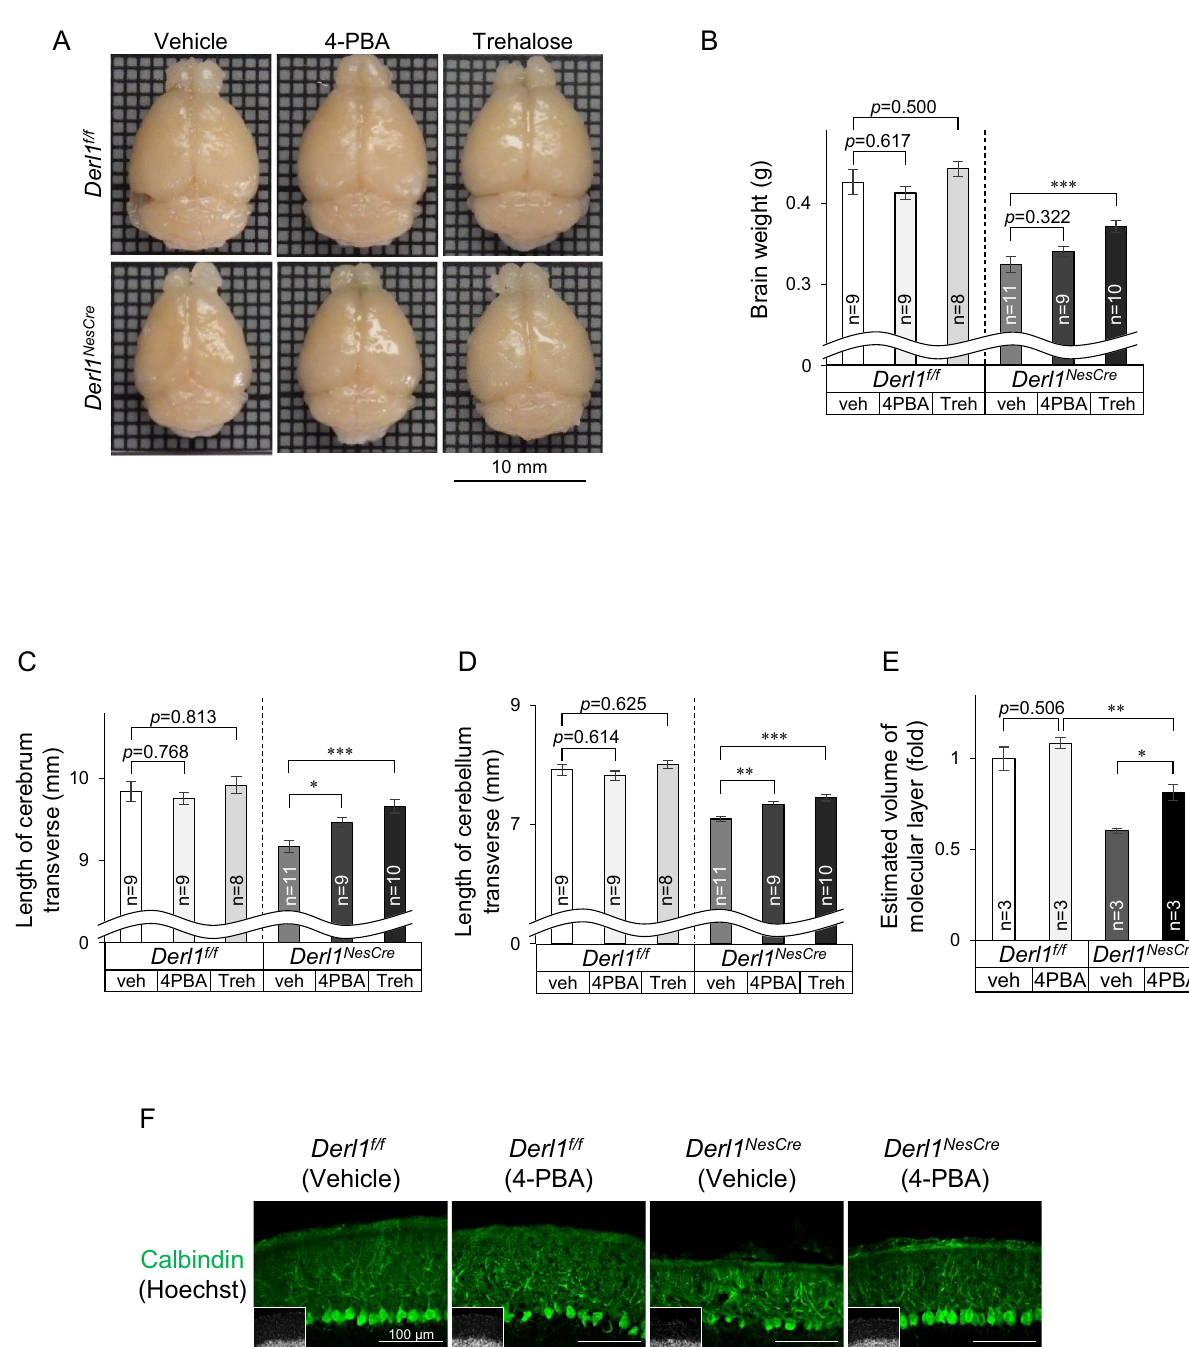
Figure 3. Chemical chaperone ameliorates brain atrophy. ( A – F ) Vehicle or chemical chaperone was administered via intraperitoneal injections once a day from P14 to 8 weeks of age. All mice were males ( A – F ). ( A ) Representative gross brain images between vehicle or chemical chaperone (4-PBA or trehalose)-treated Derl1 NesCre mice at 8 weeks of age. Scale bar, 10 mm. ( B ) Comparison of brain weight between vehicle or chemical chaperone (4-PBA or trehalose) treated Derl1 NesCre mice and their respective control mice. ( C , D ) Comparison of brain length between vehicle- or chemical chaperone (4-PBA or trehalose) treated Derl1 NesCr e mice and their respective control mice. Transverse diameters on photographs of the cerebrum ( C ) and cerebellum ( D ) were measured, respectively. ( E ) Volumetric analysis of the molecular layer of the cerebellum in Derl1 NesCre mice and their respective control mice at 8 weeks of age after vehicle or 4-PBA treatment. Estimated volumes of the cerebellum were calculated according to Cavalieri’s principle using manually measured areas. Data are shown as the fold change relative to the value of Derl1 f/f mice. ( F ) Immunohistochemical analysis of cerebellar molecular layer volume using anti-Calbindin-stained sections from Derl1 NesCre and their respective control mice at 8 weeks of age after vehicle or 4-PBA treatment. Data information: bar graphs are presented as mean ± SEM. * P < 0.05; ** P < 0.01; *** P < 0.001; one-way ANOVA followed by Dunnett’s test ( B – D ); one-way ANOVA followed by Tukey’s test ( E